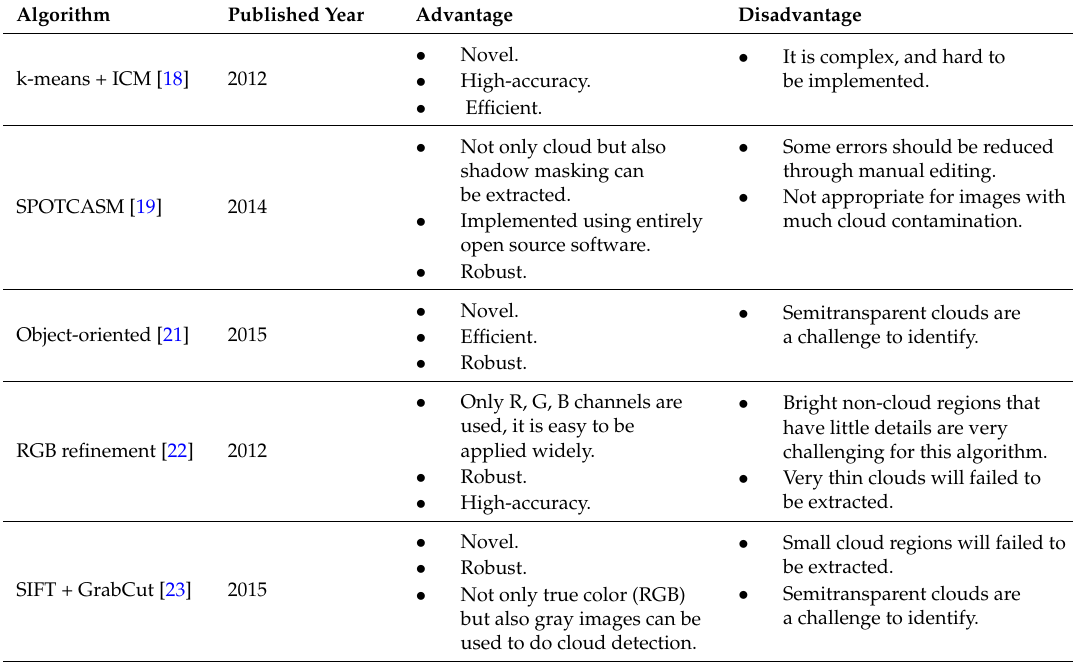
Table 1. Brief introduction of each automatic cloud detection algorithm that published in the past few